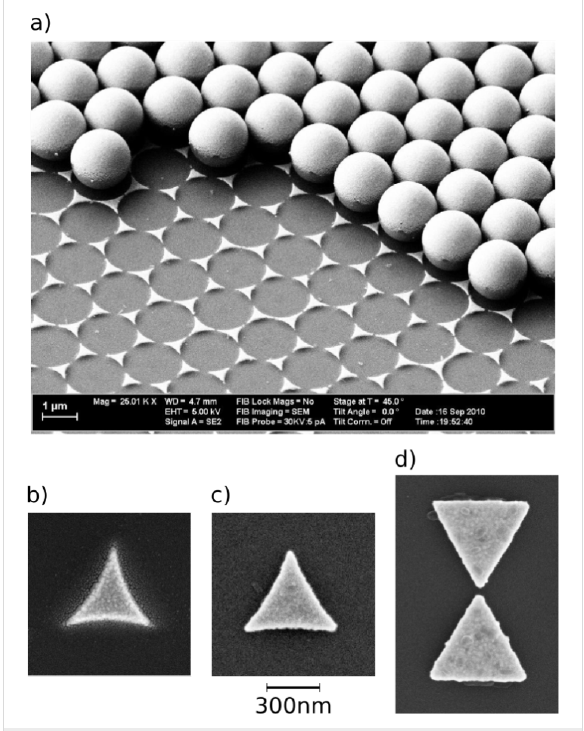
Figure 3: Scanning electron micrographs of different types of triangles used in the course of this work. The triangles in (a) and (b) were prepared by colloid lithography, the triangles in (c) and (d) were prepared by e-beam lithography. In (a) only part of the